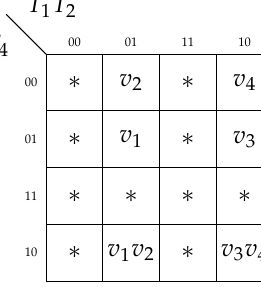
Figure 8. Karnaugh map for SBF V ( T )